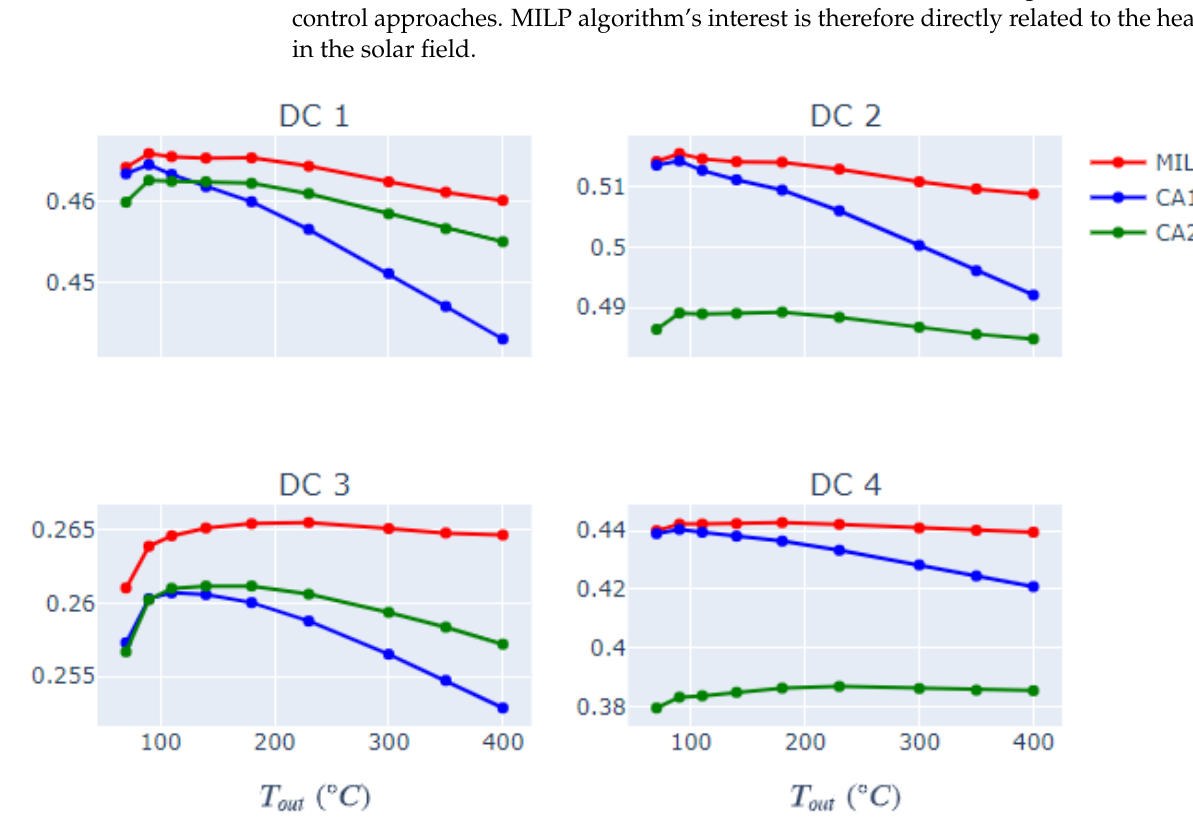
Figure 11. Evolution of Solar Fraction as a function of process temperature for the 4 demand curves and 3 control strategies.